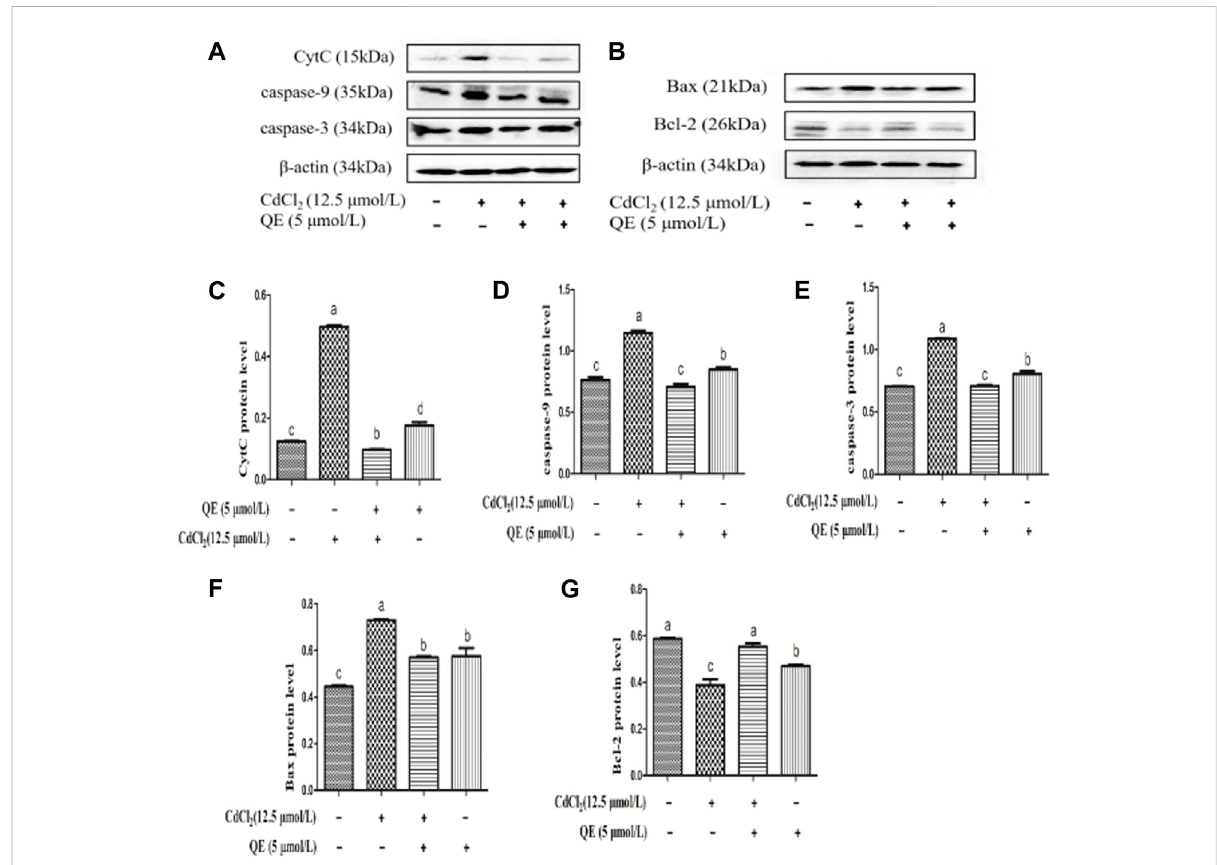
FIGURE 9 Effects of QE on Cd-induced BRL-3A cell apoptosis-related gene and protein expression. The levels of CytC, caspase-9, caspase-3, Bax and Bcl-2 proteins (A-B) were measured by Western blot. The protein levels of CytC (C) , caspase-9 (D) , caspase-3 (E) , Bax (F) and Bcl-2 (G) in BRL-3A cells. The data are expressed in the form of mean ± SEM, and data with different letters (a, b, and c) represent signi fi cantly different ( p < 0.05) among different